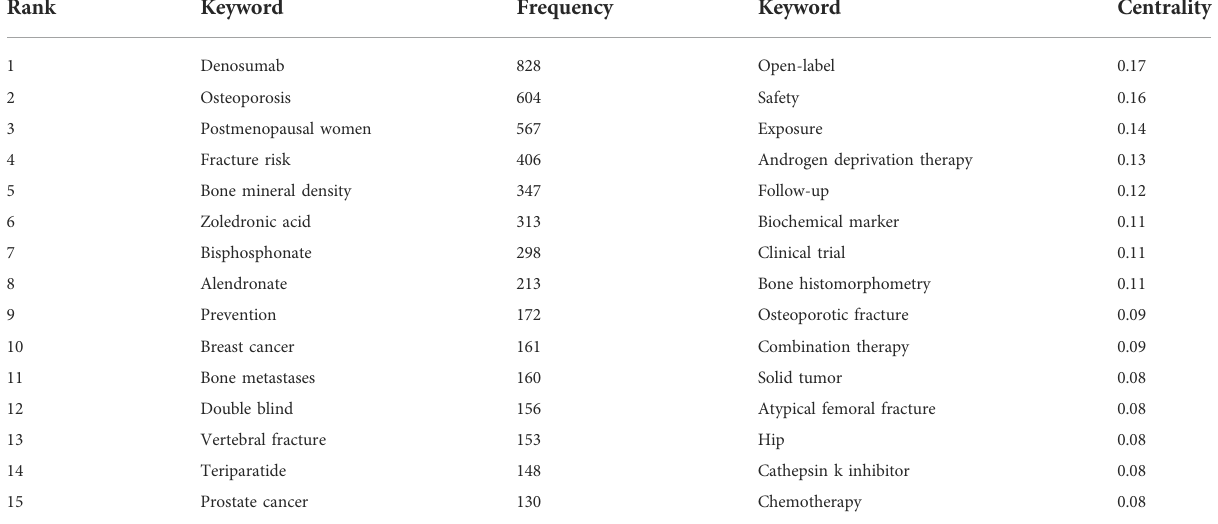
TABLE 6 Top 15 keywords in terms of frequency and centrality.